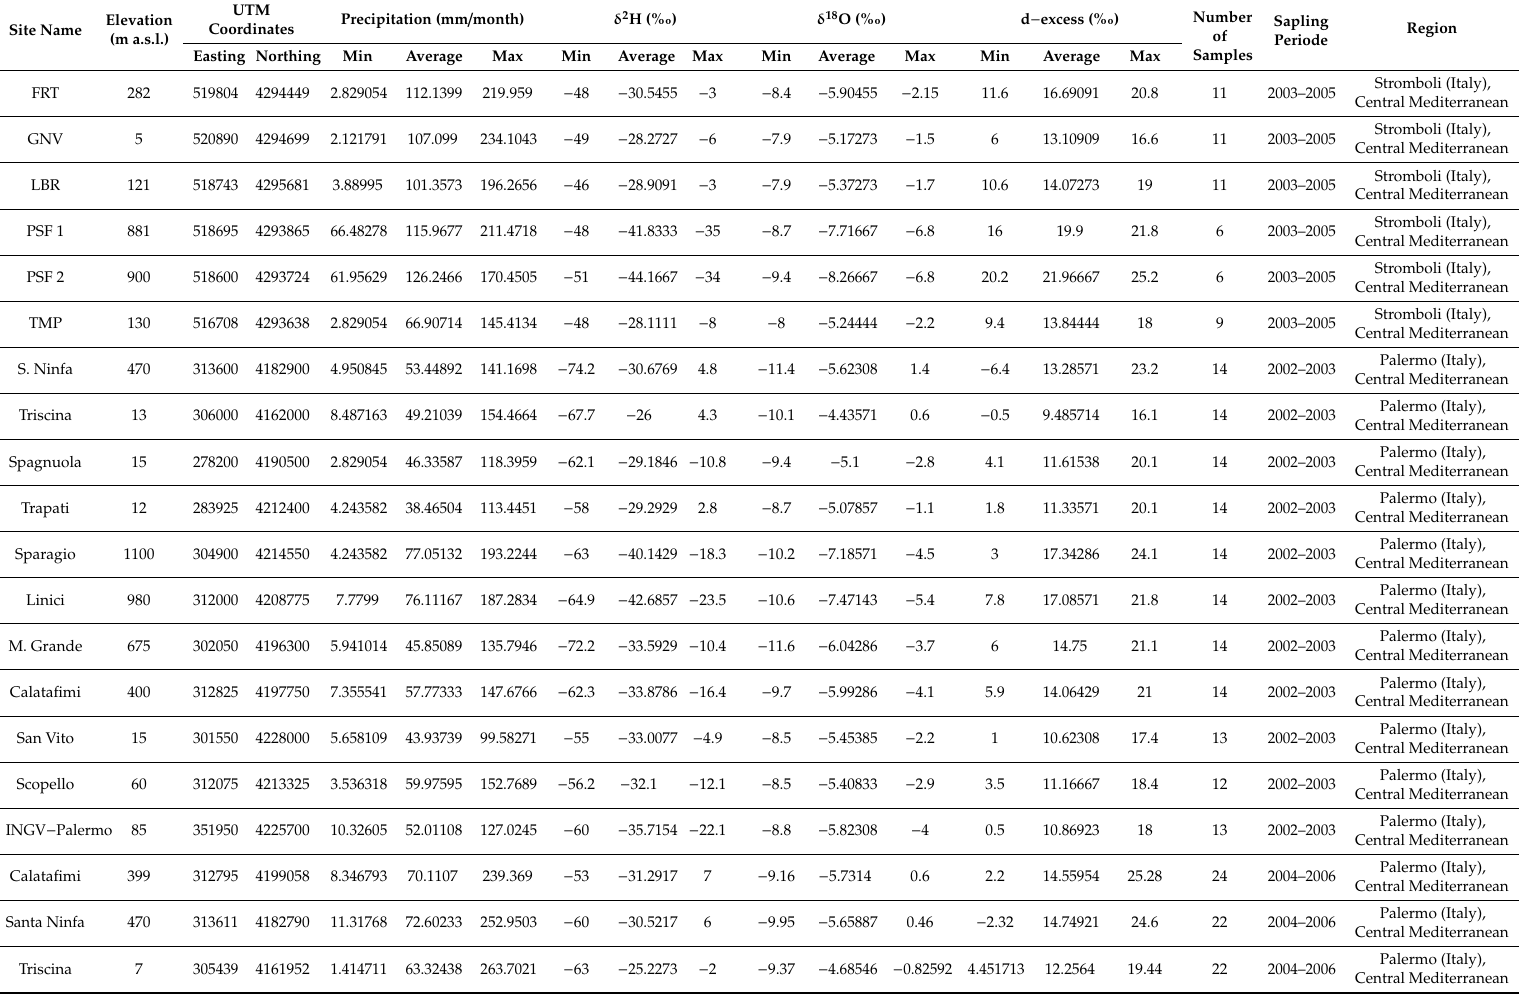
Table 1. Sampling sites elevation (meter, m), monthly min, average and max δ 2 H, δ 18 O and deuterium excess (per mil) of rainwater collected on a monthly basis in Central Mediterranean (Stromboli and Sicily, Italy) and in Central-Eastern Africa (at Mount Nyiragongo and the surroundings, Democratic Republic of the Congo). Site Name Elevation (m